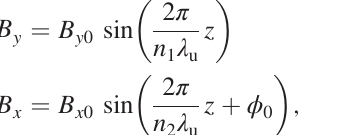
is preserved on the axis. Figures 2(b) and 2(d) indicate that the electron velocity is always deviated from the undulator axis, thus the on-axis heat load can be greatly suppressed.